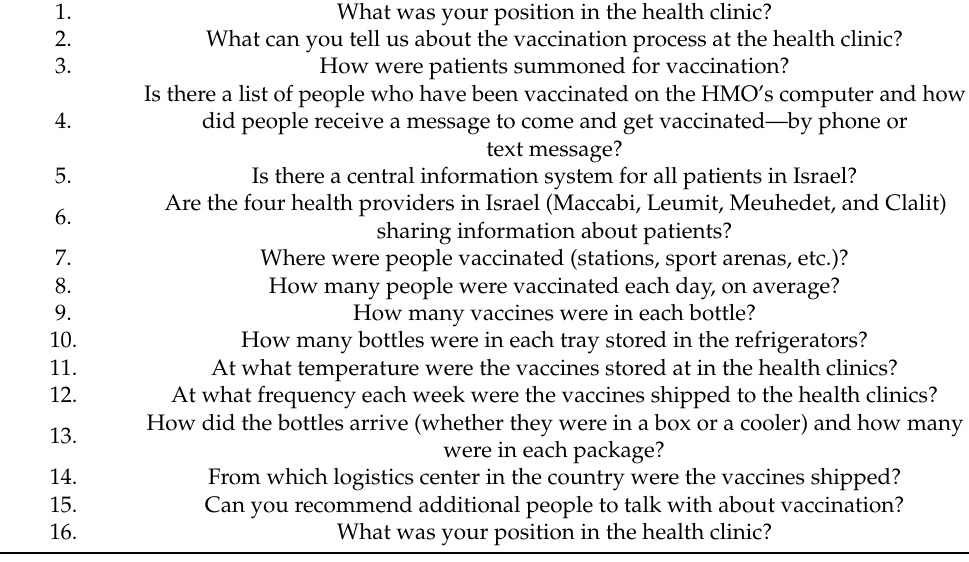
Table 3. Questionnaire for the interviews with the employees at the health